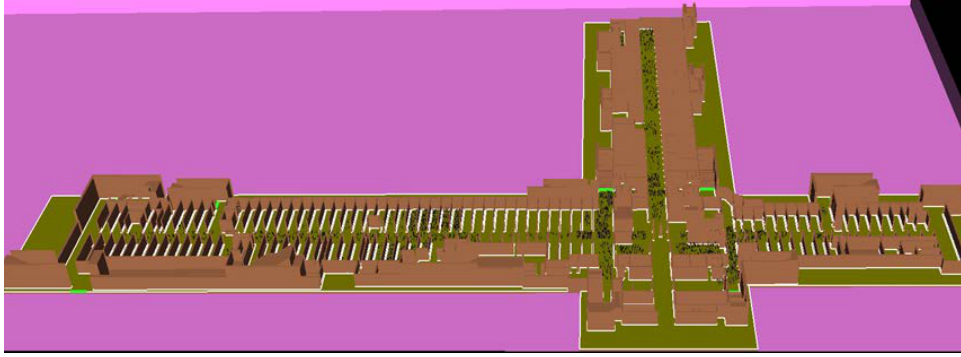
Figure 6. The underground commercial street of Wanda Plaza. Table 2. The summary of occupants’ basic statistics information.